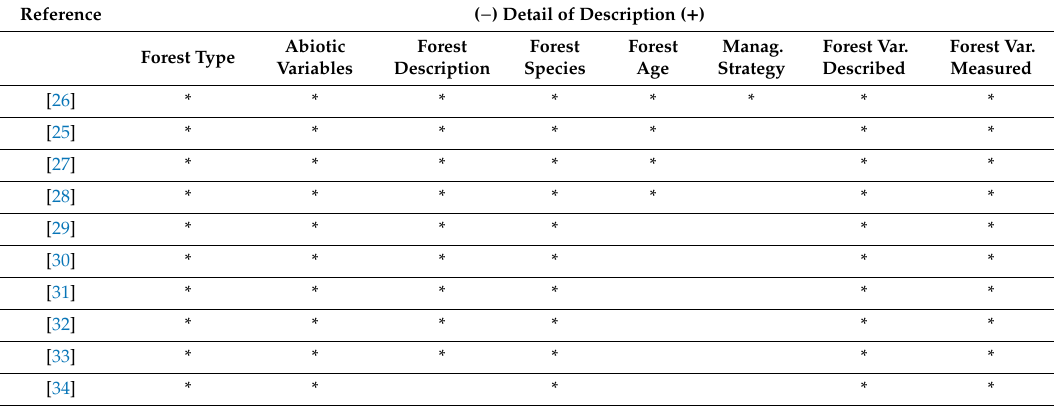
Table 1. Details of forest descriptions. Symbol “*” indicates that the article provides the forest description information. Manag. Strategy, management strategy; Forest var. described, forest variables described; and Forest var. measured, forest variables